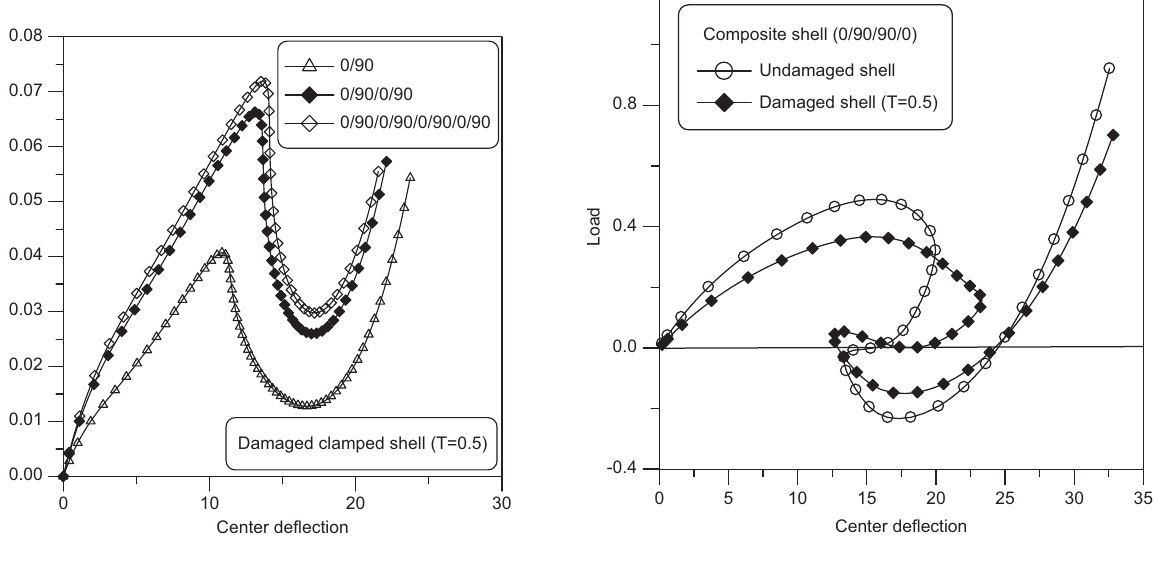
Figure 18 Load-displacement curves of hinged cylindrical